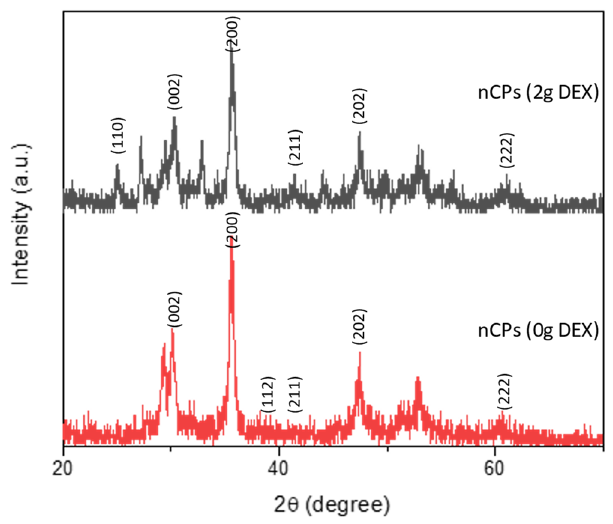
Figure 3. XRD of nCPs (0gDEX) and nCPs (2gDEX). The FTIR spectra of the nCPs (0g DEX) and the nCPs (2g DEX) synthesized by the co-precipitation method are shown in Figure 4. A small common absorption peak at 740–742 cm − 1 marked at dashed line I and an intense peak marked at dashed line II at 850–870 cm − 1 contributed to the O–O stretching vibrations [36]. The carbonate ion (CO 32 − ) was detected as a weak absorption peak between 1075 and 1080 cm − 1 , but this peak is relatively small (dashed line III). In the spectra for both nCPs (0g DEX) and nCPs (2g DEX), an intense peak near 1450–1470 cm − 1 can be observed (dashed line IV). The peak indicated the pres- ence of the bending vibration of O–Ca–O of CaO 2 and the CO 32 − (carbonate) group of cal- cites. A signal at 1650 cm − 1 at dashed line V was attributed to the stretching mode of the band of the H–O–H bending of residual free water in the nCPs (0g DEX) and nCPs (2g DEX), respectively. The bands at 3190–3490 cm − 1 in dashed line VI correspond to the O–H mode of vibration. This was attributed to the vibrational mode O–H bond of the hydroxyl group that might come from water adsorbed by the nCPs (0g DEX) and nCPs (2g DEX) from the humid atmosphere or moisture from the sample itself. Figure 4. FTIR of nCPs (0gDEX) and nCPs (2gDEX). Figure 5a,b show the TGA thermogram analysis of nCPs (0g DEX) and nCPs (2g DEX) together with their DTG. The TG curves show that weight loss occurs in three stages for